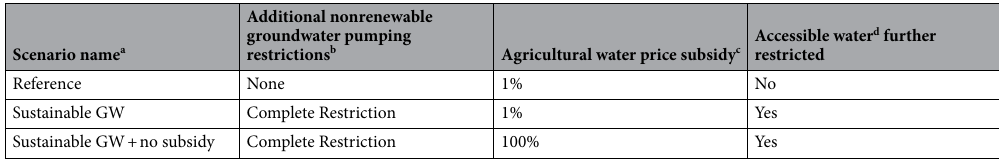
Table 1. Scenario naming and component breakdown. a Intermediate scenarios are explored in the Supplementary Information. b In addition to the level of water constraints already present in GCAM-USA. Begins in the first future period. c Relative to all other sectors. d Calculated from the hydrologic model Xanthos 37, 38 and using Turner et al.